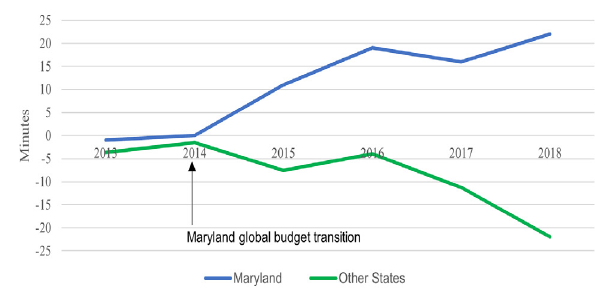
Figure 1. Cumulative absolute change in time from